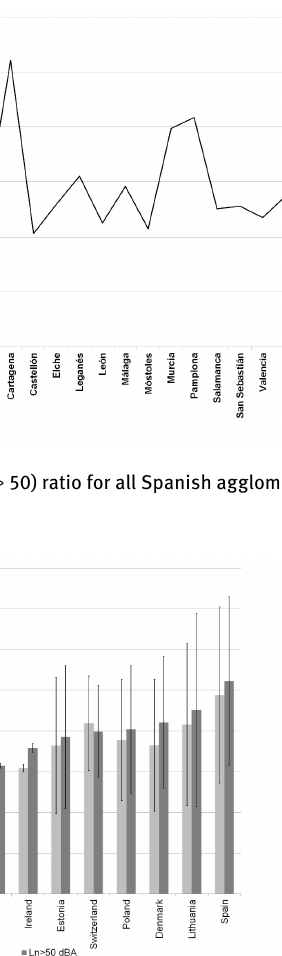
Figure 4: Percentage of the population exposed to traflc noise ( L den > 60 dBA and L n > 50 dBA) in European countries (agglomer- ations). Error bars show the standard deviation among cities within the country.